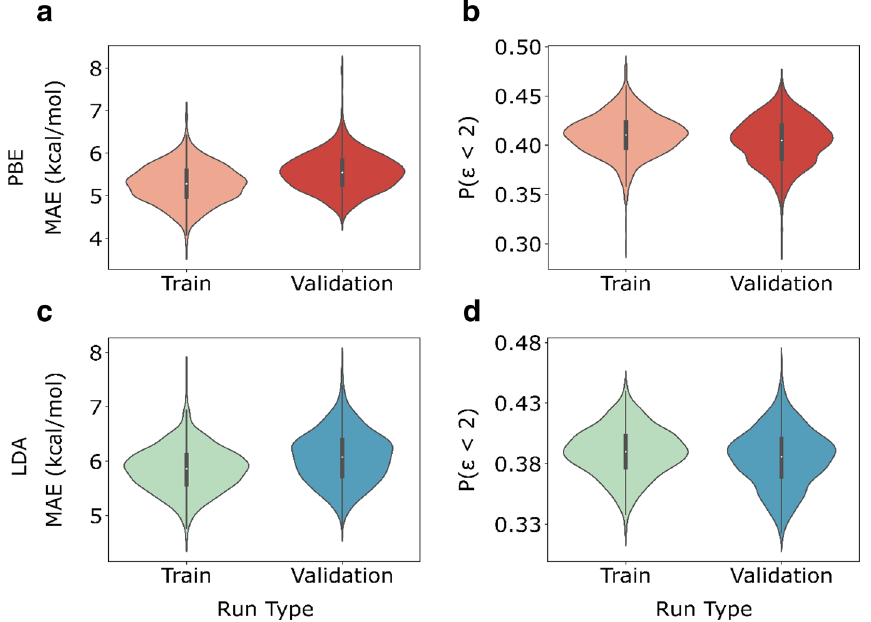
Figure 5. Violin plots of train and validation MAE during bootstrap simulations of the ( a ) PBE and ( c ) LDA model. Violin plots of train and validation P ( ǫ < 2) during bootstrap simulations of the ( b ) PBE and ( d ) LDA